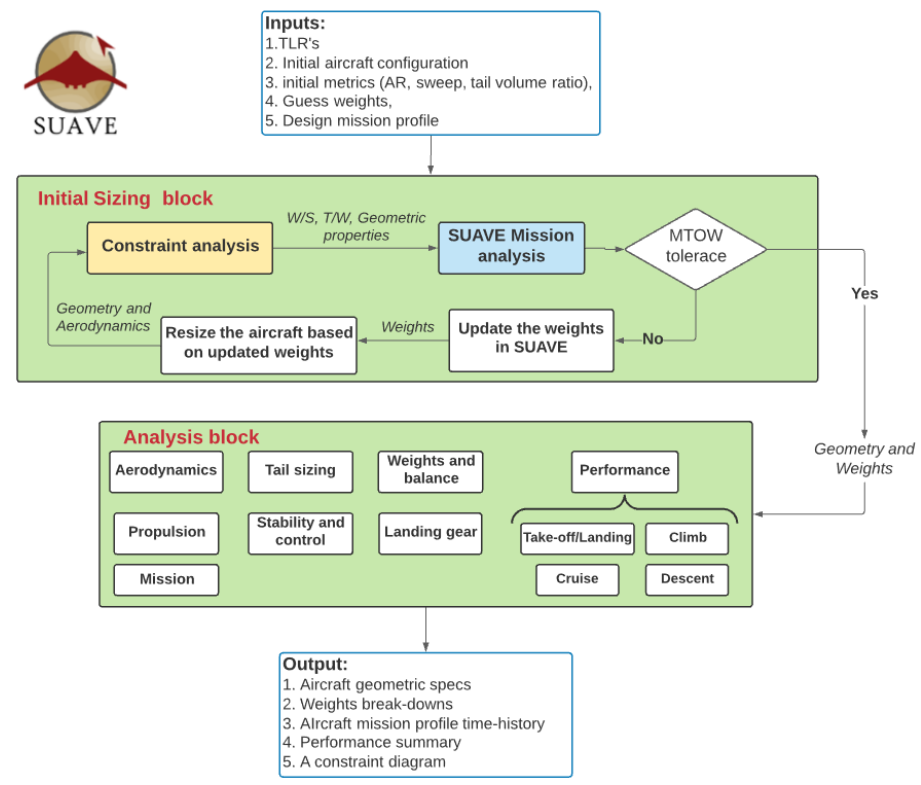
Figure 5. Initial aircraft sizing framework using